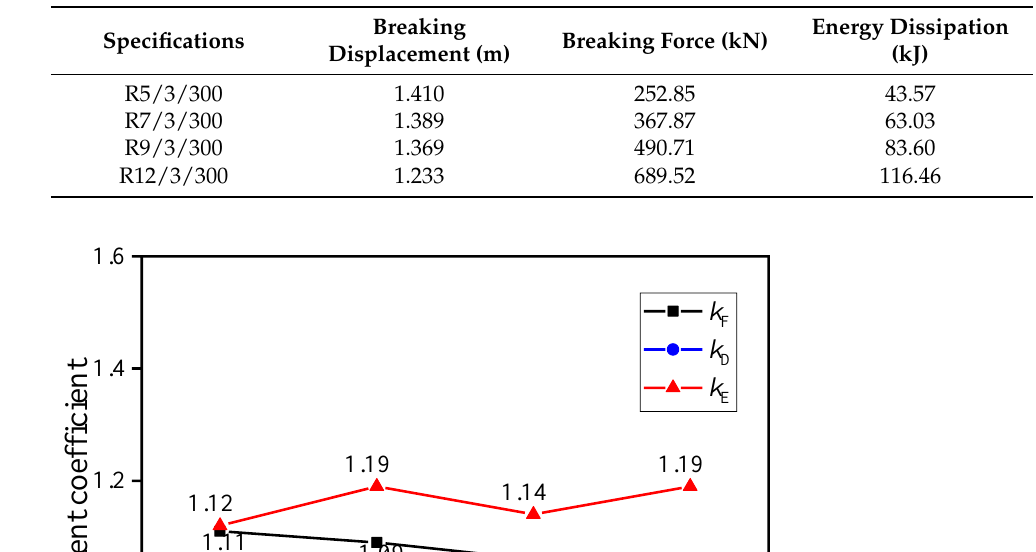
Table 5. Equivalence breaking force and breaking displacement of ring nets with different specifi-